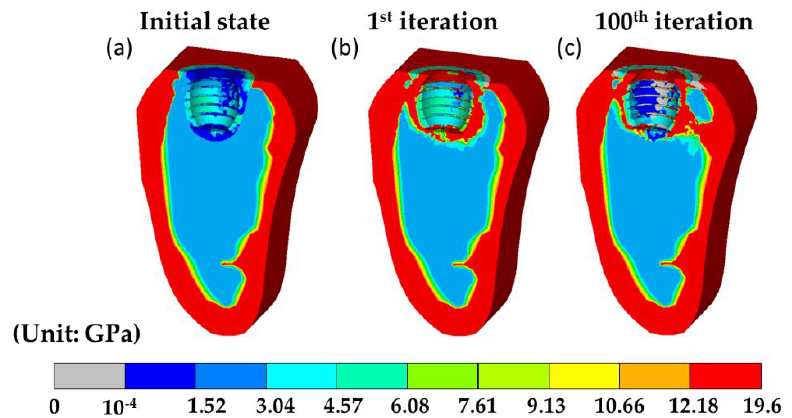
Figure 8. The results generated by the current model in higher bone strength case. ( a – c ) are the corresponding distribution of Young’s modulus during the bone remodeling process at the initial state, 1st, and 100th iteration.